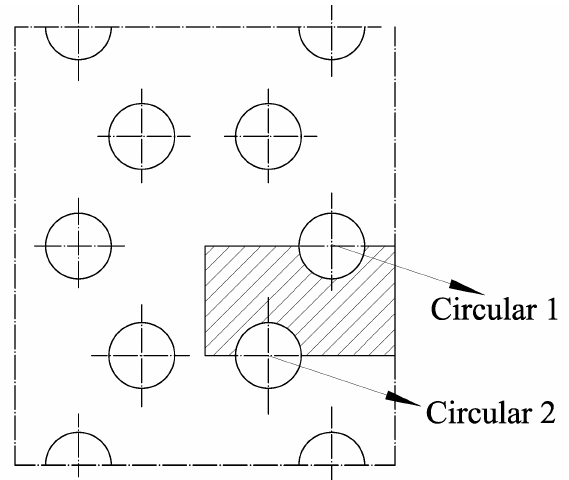
Figure 11. Simulation unit of triaxial geogrid. The triaxial geogrid simulation unit has a length of 8.7 mm, a width of 5 mm, and a thickness of 4 mm. In Figure 11, the distance between the center of Circular 1 and the right boundary of the simulation unit is 2.9 mm, and the distance between the center of Circular 2 and the left boundary of the simulation unit is 2.9 mm. Once the basic elements of the simulation are set up, heat transfer simulations, and biaxial stretching simulations can be performed.